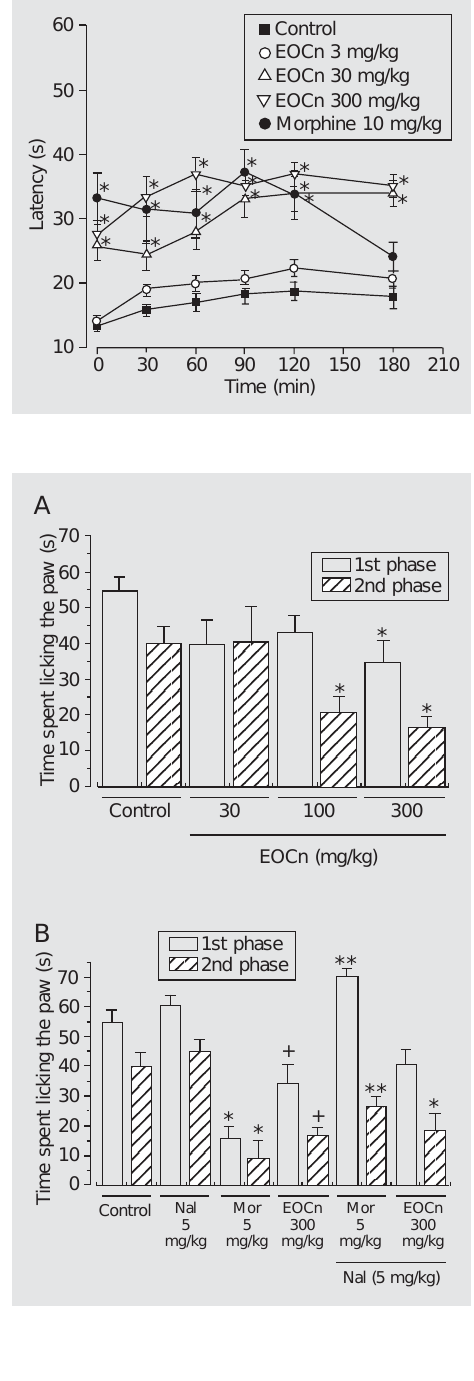
Figure 1. Antinociceptive effect of the essential oil of Croton nepetaefolius (EOCn) in the hot- plate test. Each point represents the mean ± SEM, indicated by vertical bars. Abscissa, time in min (0 time: 60 min after per os administration of EOCn or 30 min after subcutaneous admin- istration of morphine); ordinate, latency time (s) for the response to thermal stimulation (50.0 ± 1 º C). N = 12 for each EOCn dose and N = 6 for morphine. *P (cid:1) 0.05 compared to control (ANOVA, Dunnett test) at a given time.